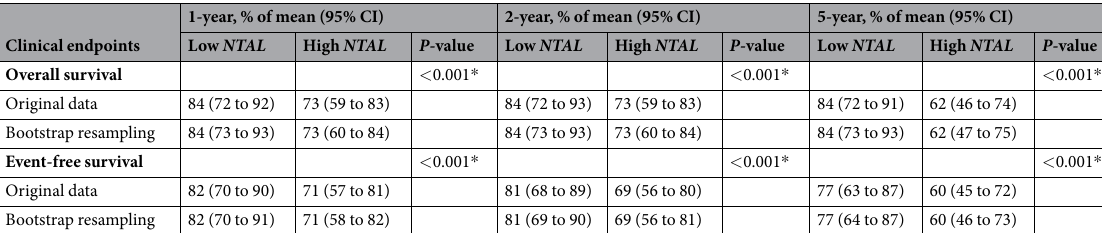
Table 3. Summary outcomes of patients according to the NTAL expression considering the original data and the bootstrap resampling. * Welch two samples t-test. Abbreviation: CI: confidence